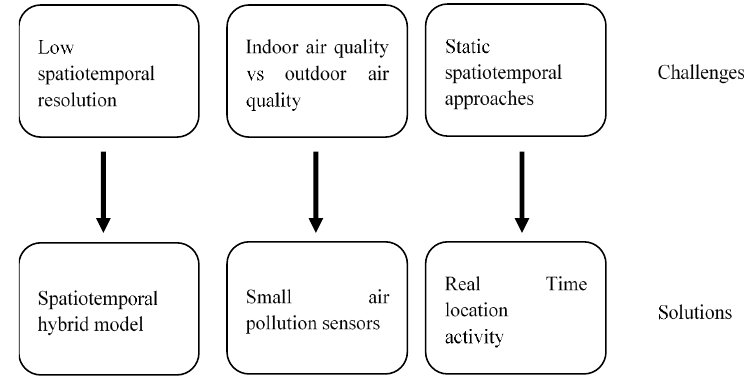
Figure 1. Exposure assessment challenges and their novel solutions.